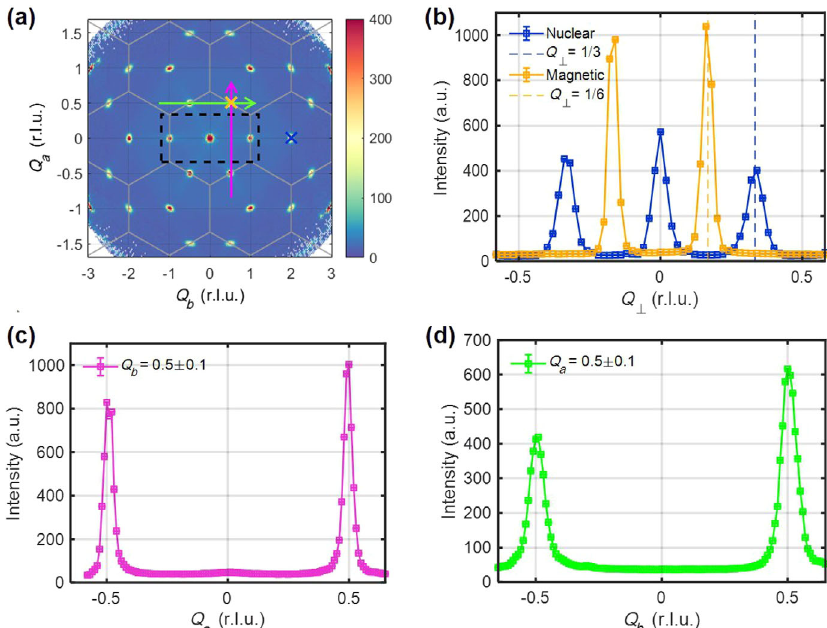
FIG. 3. (a) Q ⊥ -integrated diffraction data measured at 6 K and in zero field. Gray hexagons indicate 2D Brillouin zones. Color-coded crosses and arrows indicate locations of line cuts in (b) – (d). The dashed box indicates the restricted data coverage in Fig. 4. (b) Line cuts along Q ⊥ through nuclear and magnetic Bragg peaks. The nuclear peaks at Q ⊥ ¼ 0 and (cid:4) 1 = 3 are contributed by physical reflections ð 0 ; 2 b (cid:3) ; 0 Þ of S and ð a (cid:3) ; b (cid:3) ; 0 Þ of S 60 , respectively. The magnetic peaks at Q ⊥ ¼ (cid:4) 1 = 6 are contributed by reflections a ð(cid:4) a (cid:3) = 2 ; (cid:4) b (cid:3) = 2 ; 0 Þ of both domains. (c),(d) Line cuts along Q and Q through the magnetic reflections. The map in (a) is a b symmetrized, whereas the line cuts in (b) – (d) are not